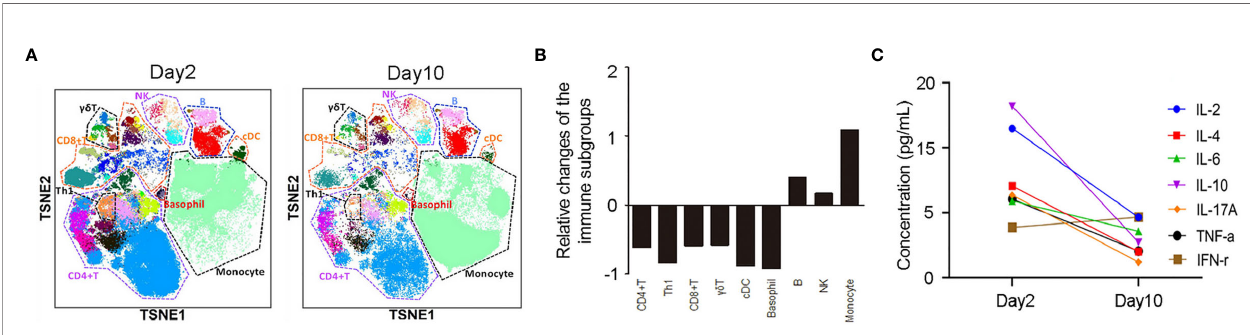
FIGURE 3 | (A) t-distributed stochastic neighbor embedding images of immune cell subgroups in the peripheral blood of the patient on Day 2 and Day 10. (B) The relative log 2 -fold changes of the percentages for each immune cell subgroup reveals a signi fi cant reduction of CD4+ and CD8+ T cells with stable levels of B cells and NK cells on Day 10. (C) Cytometric bead array demonstrated a signi fi cant reduction of IL-2, IL-4, IL-6, IL-10, IL-17A, and TNF- a levels and slight elevation of IFN- g levels on